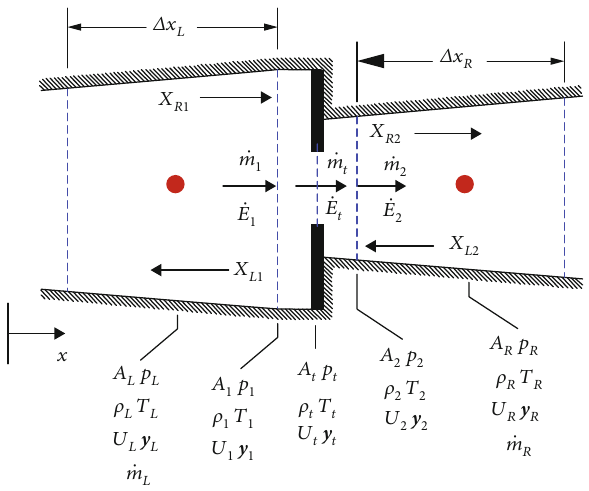
Figure 4: Schematic of adjoined pipes with restrictive ori fi